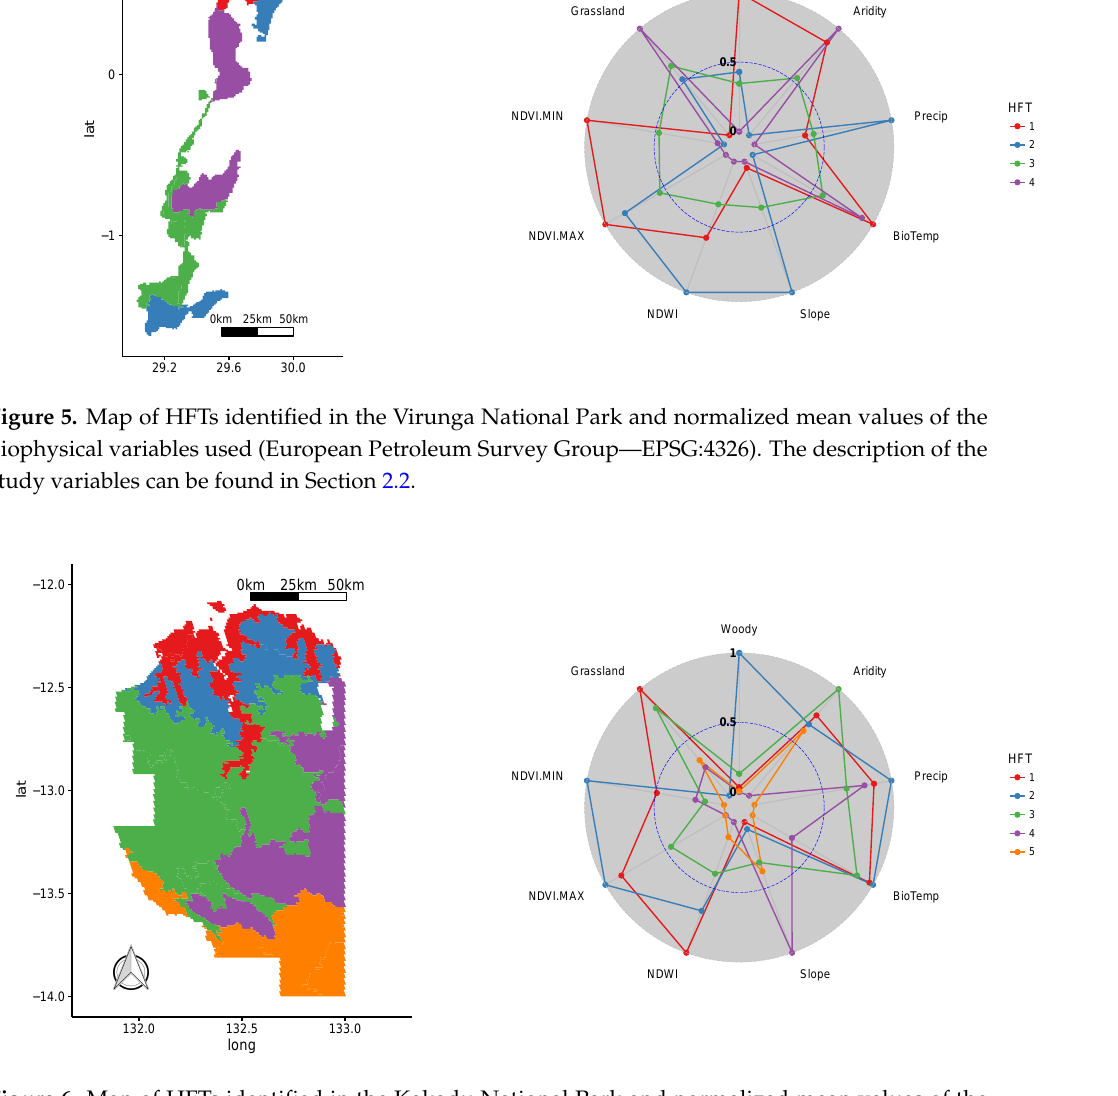
Figure 6. Map of HFTs identified in the Kakadu National Park and normalized mean values of the biophysical variables used (European Petroleum Survey Group—EPSG:4326). The description of the study variables can be found in Section